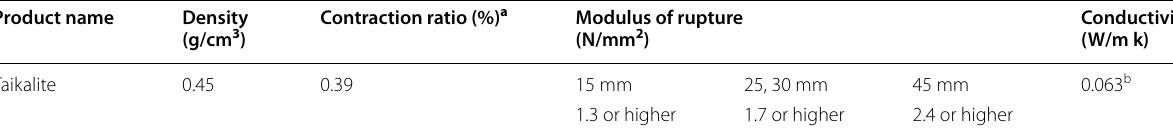
Table 4 Material properties of fire